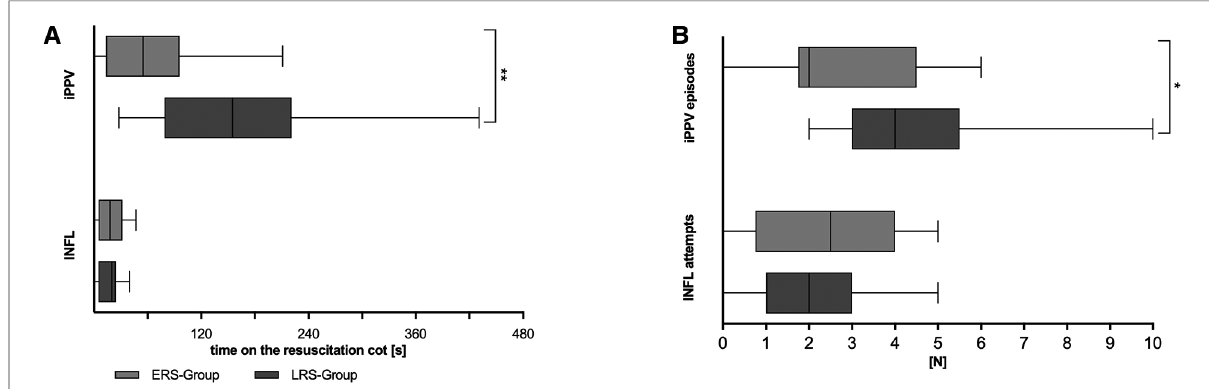
FIGURE 1 Respiratory support. Overall time used for intermittent positive pressure ventilation (iPPV) or initial in fl ations (INFL) ( A ) as well as iPPV-episodes and INFL-attempts ( B ) are shown for the LRS, late respiratory stability group and ERS, early respiratory stability group during the fi rst 15 min of postnatal support. p -values - ** p =0.004, * p